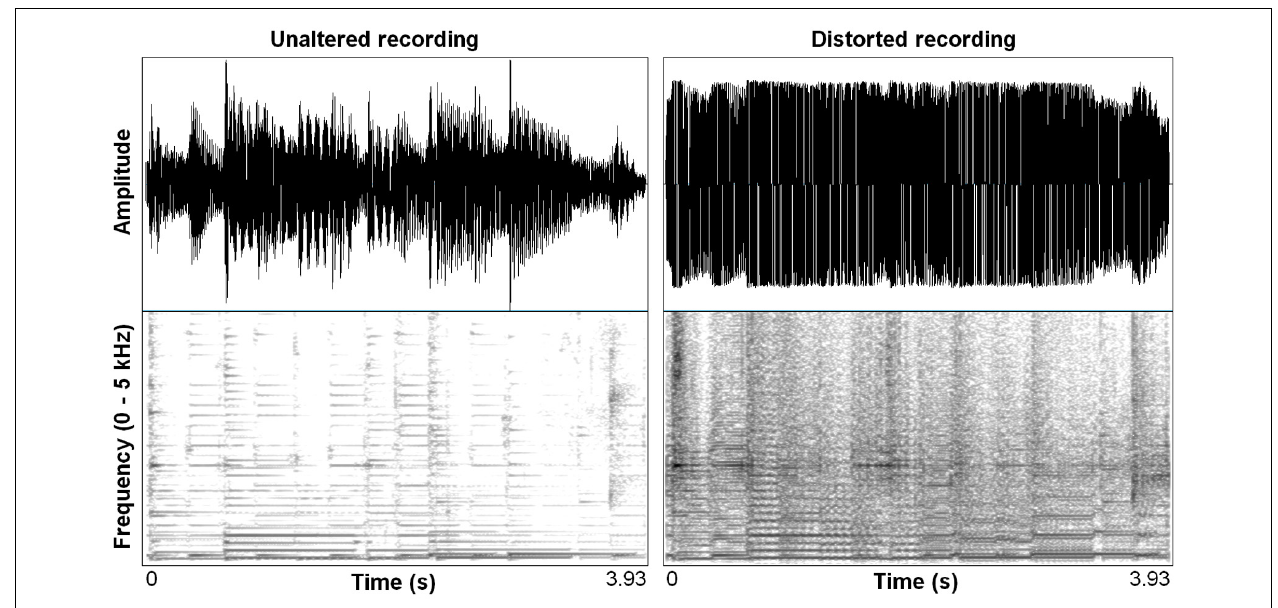
FIGURE 2 |Waveform and spectrogram (FFT method, window length – 0.005 s., Gaussian window shape, dynamic range – 50 dB) of an acoustic guitar melody unaltered, and distorted using a wave shaping function (Camel CrusherVST Plug-in).